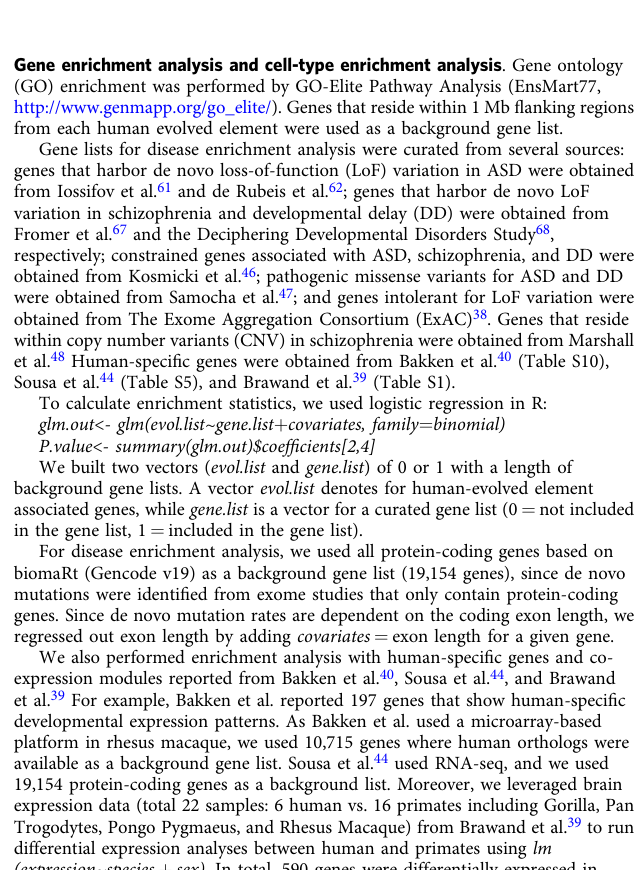
Table 1 Contingency table for calculating cell-type speci fi c enrichment of HARs DHS Not DHS Row total HAR # of HARs that overlap with DHS in a given cell # of HARs that do not overlap with DHS in a given type = A cell type = D Background (evolutionary # of evolutionary conserved regions that # of evolutionary conserved regions that do not conserved regions) overlap with DHs in a given cell type = B overlap with DHS in a given cell type = D Column total A + B C + D N ( = A + B + C